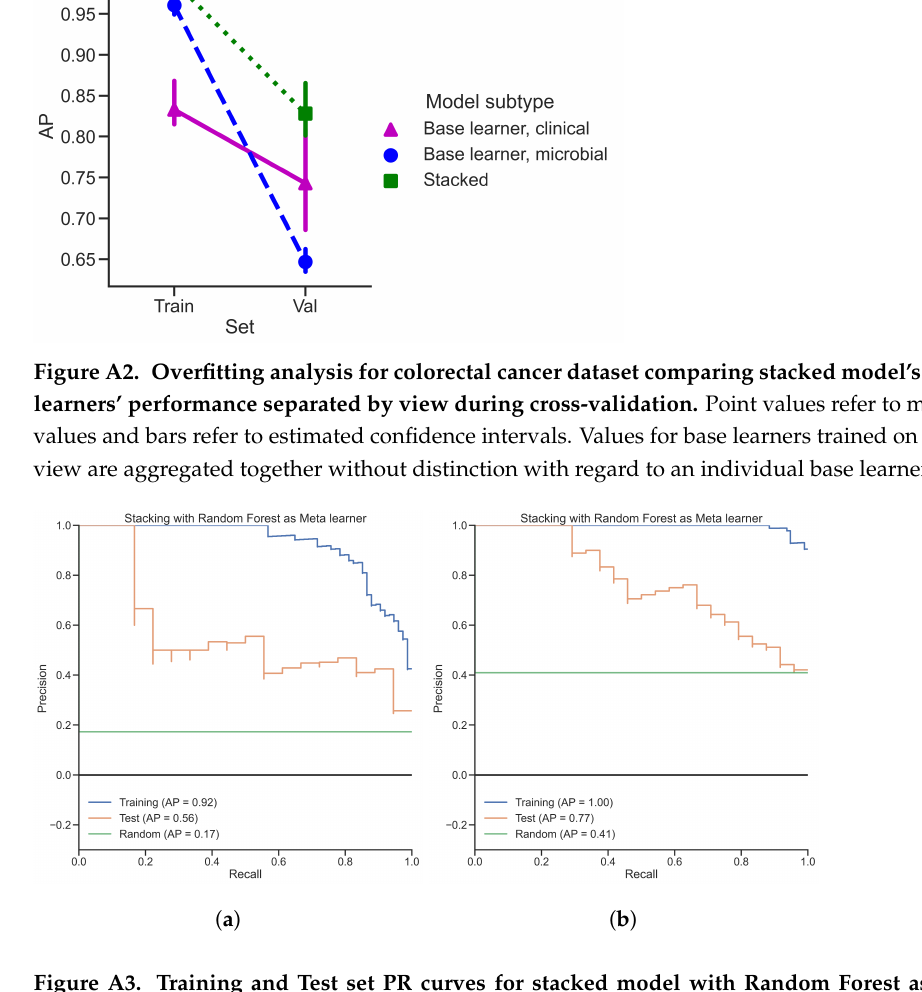
Figure A3. Training and Test set PR curves for stacked model with Random Forest as a meta learner. ( a ) Inflammatory bowel disease dataset; ( b ) Colorectal cancer dataset.